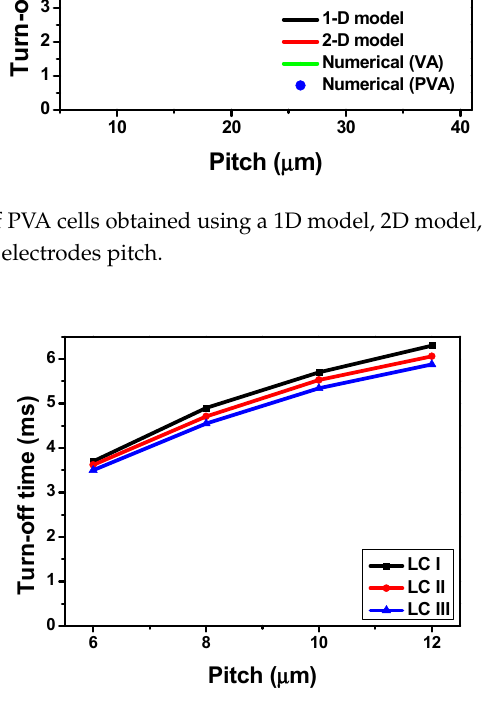
Figure 4. Turn-off times of PVA cells obtained using three different LC materials as a function of patterned electrodes pitch. Table 1. Elastic constants of the three different LC materials used in our numerical calculation.